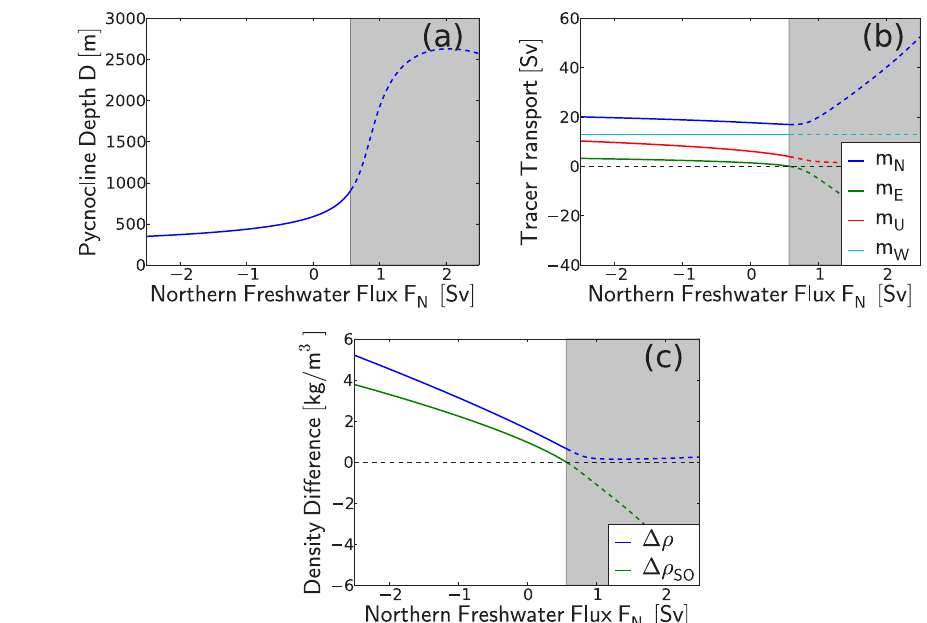
Figure 3. In steady state only one real stable solution of the governing equation of the full case exists. This solution increases under freshwater forcing (a) . The tracer transport processes show different behaviours (b) . The eddy return flow m E decreases ( b , green line) until it becomes negative and the break down of circulation is reached (grey shaded area). Also the density difference between the southern box and the low-latitudinal box, 1ρ SO , crosses zero at the threshold level ( c , green line). See also Fig. 1 for explanation of the tracer transports m and the density differences.